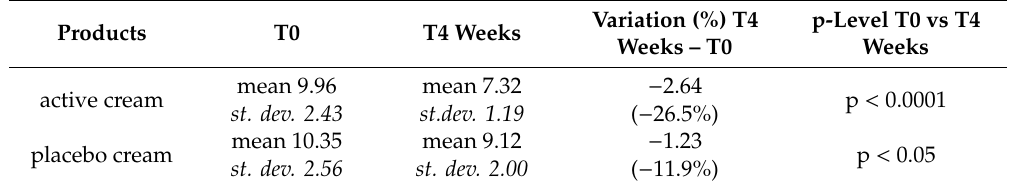
Table 7. Mean values, standard deviations, variations and statistical significance (t-test).